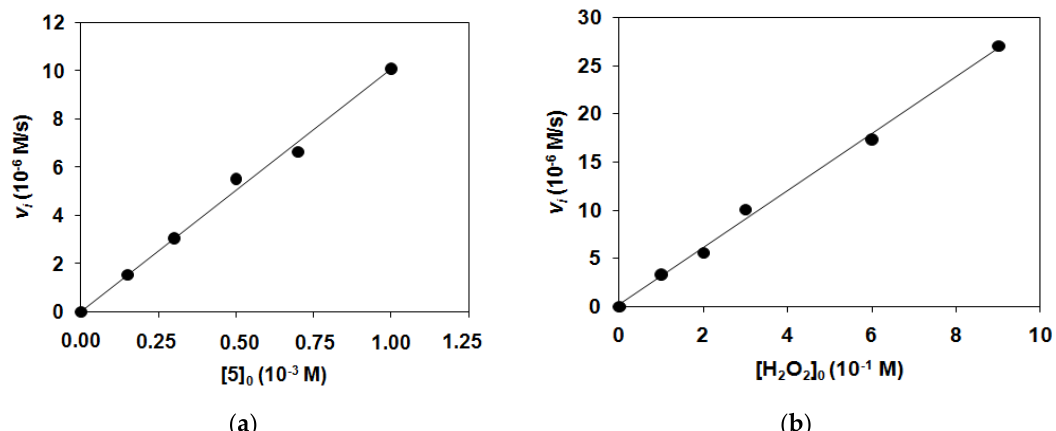
Figure 5. 5 -mediated disproportionation of H 2 O 2 in CH 3 CN at 25 ℃ . ( a ) Dependence of the reaction rate ( V i ) for H 2 O 2 oxidation on the diiron-peroxo complex 5 concentration. [H 2 O 2 ] 0 = 300 mM ( b ) Dependence of the reaction rate ( V i ) for H 2 O 2 oxidation on the H 2 O 2 concentration. [ 5 ] 0 = 1 mM. Table 3. Kinetic data for the disproportionation of H 2 O 2 mediated by 5 , 6 , 7 and 8 in CH 3 CN.